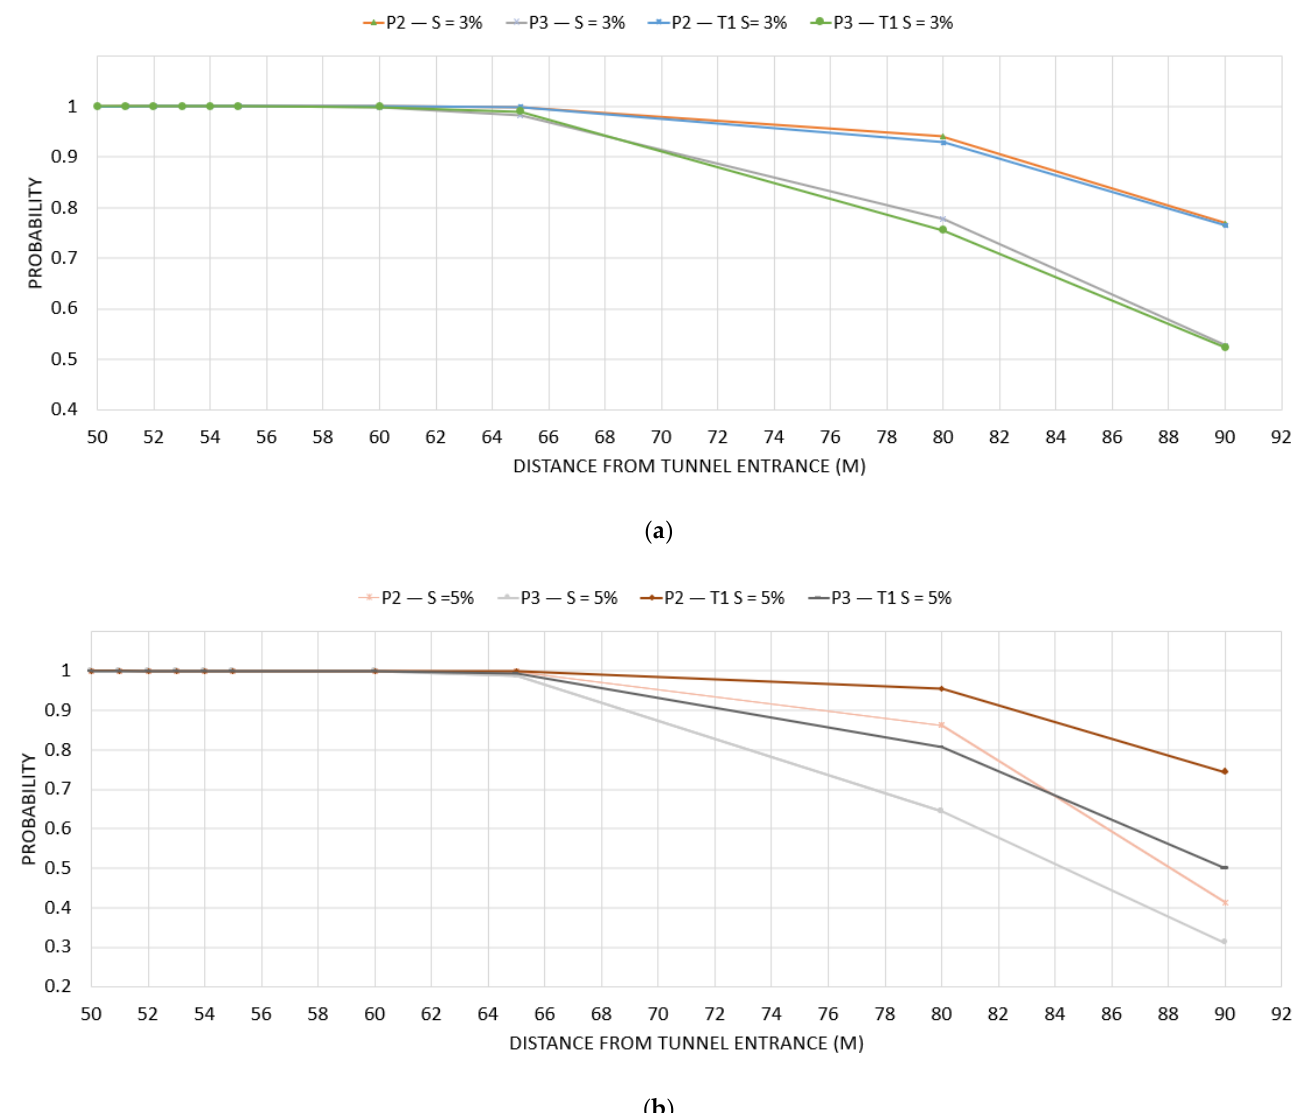
Figure 15. ( a ) 3% slope with V L = 2.5 m/s compared to 3% slope with combined ventilations V L = 2.5 m/s and V T = 1 m/s. ( b ) 5% slope with V L = 2.5 m/s compared to 5% slope with combined ventilations V L = 2.5 m/s and V T = 1 m/s. P2 and P3 refer to the probability of second and third burn injuries, respectively.